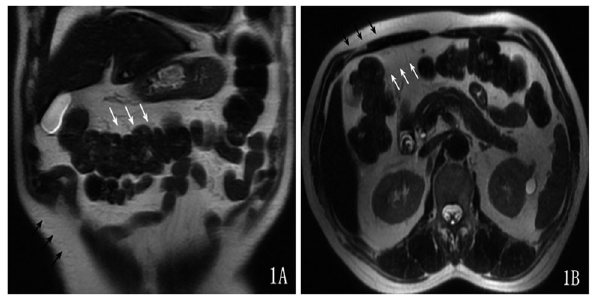
Figure 3. The gastrocolic trunk was shown on the axial enhancement image (A) and on the enhancement coronal image